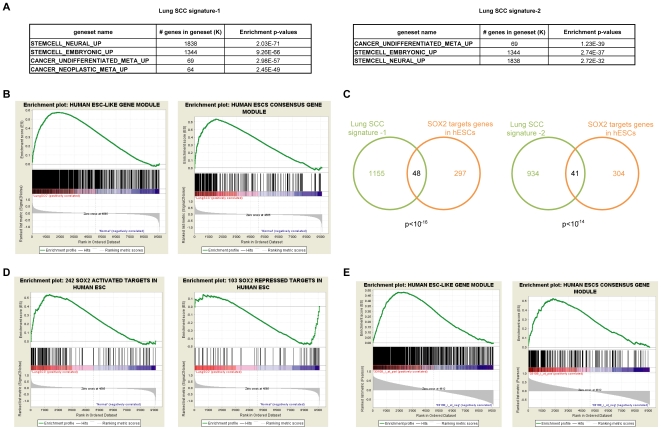
A global SOX2 imprint on the lung SCC transcriptome towards an embryonic stem cell-like molecular phenotype.
A. Selected molecular signatures enriched in the lung SCC signatures −1 and −2. For each signature, enrichments were queried using the molecular signatures database. Highly significant enrichment of both embryonic and neural stem cell-specific molecular signatures was observed in the lung SCC transcriptome (all with p<10−31, hypergeometric distributions). B. Enrichments of ESC-like gene modules with known relevance for epithelial cancers in lung SCCs. The GSEA tool was used to query enrichments of the human ESC-like (left panel) and the human ESC consensus (right panels) gene modules in the lung SCC dataset-1. Significant enrichments are observed in lung SCCs (both FDR <0.02). C. Venn diagrams of the overlaps between the 345 SOX2 target genes in hESCs and the lung SCC signatures −1 (left graph) or −2 (right panel). Gene numbers are indicated within the corresponding sections, and the p-value is below each graph (hypergeometric distribution). D. Enrichments of known SOX2 target genes in lung SCCs (dataset-1). The GSEA tool was used to query enrichments of SOX2 target genes that are activated (left panel) or repressed by SOX2 (right panel) in human ESCs. Significant enrichment of SOX2-activated target genes is observed among genes over-expressed in lung SCCs (FDR <0.03) and of SOX2- repressed genes among genes under-expressed in lung SCCs (FDR  = 0.13). E. Enrichments of ESC-like gene modules with known relevance for epithelial cancers among genes correlated to SOX2 expression in lung SCCs. The GSEA tool was used to query enrichments of the human ESC-like and the human ESC consensus gene modules in the lung SCC dataset-1 using SOX2 expression to define phenotypes. Significant enrichments are observed (both FDR <0.05).